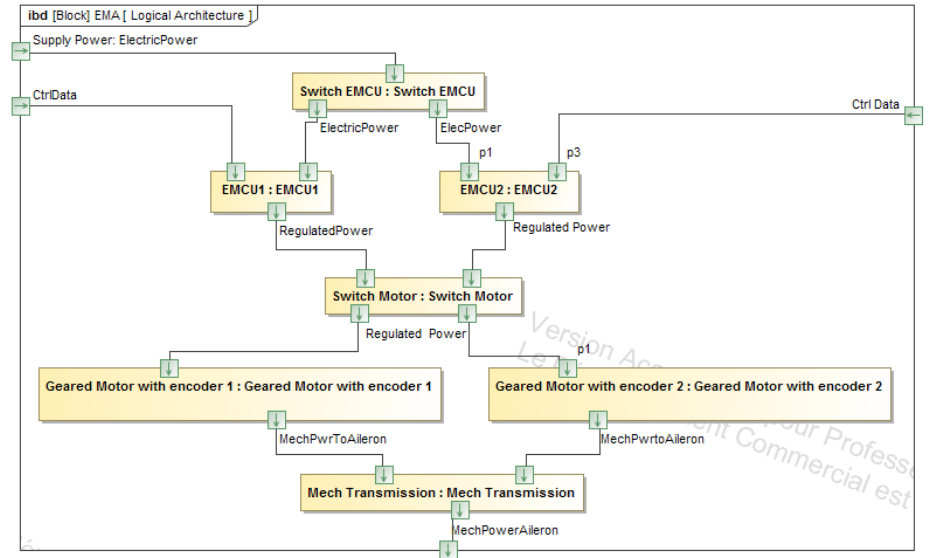
Figure 6. Updated structure of the system. Table 3. New FMEA for